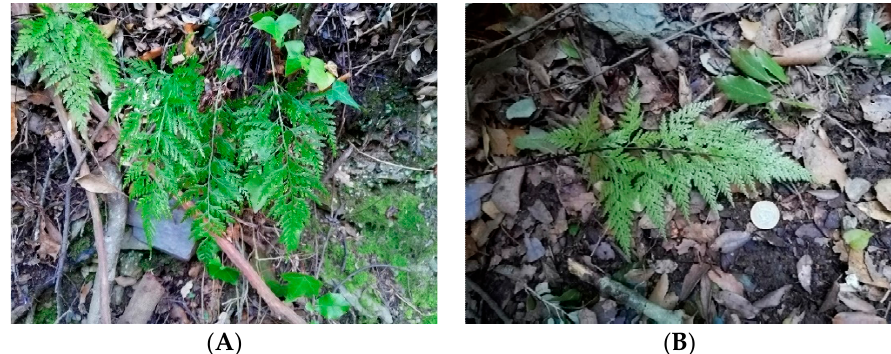
Figure 1. Face fronds ( A ) and underside frond ( B ) of fresh Asplenium adiantum-nigrum L. ( Aspleniaceae ) at the Prades mountains by Adrià Farràs. The euro coin provides a reference for the size of frond ( B ). The extracts from the Asplenium trichomanes L. and Asplenium nidus L. (also reported as Asplenium australasicum (J. Sm.) Hook.) fronds, ferns from Aspleniaceae family, have been described for the treatment of burns (oily extract) and for wound healing (aqueous-